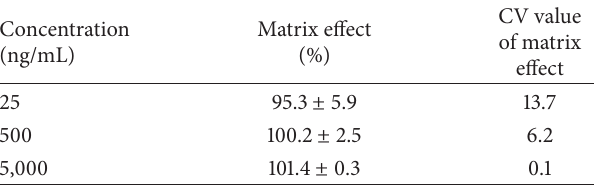
Table 3: Matrix effect of propofol in human plasma ( 𝑛 = 6 ).